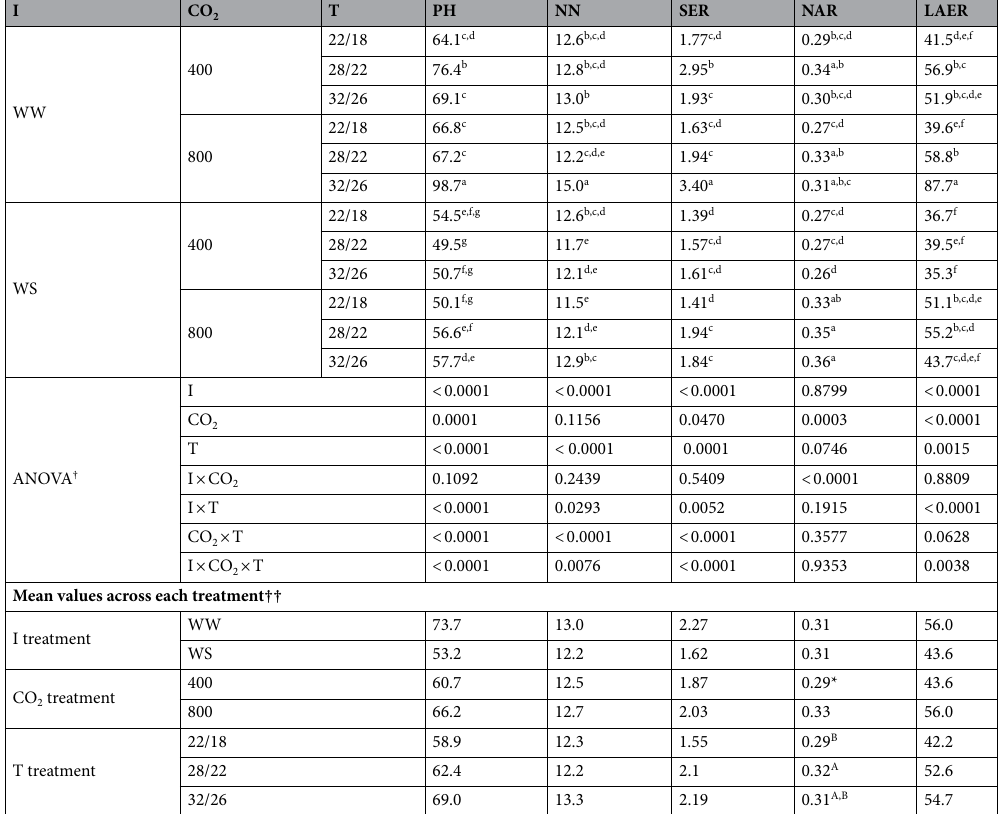
Table 1. Effects of irrigation (I, WW, well water; WS, water stress), CO 2 levels (µmol mol −1 ), and temperature (T, day/night, °C) treatments on plant height (PH, cm), mainstem node number (NN), stem elongation rate (SER, cm/day), node elongation rate (NAR, node/day) and leaf area expansion rate (LAER, cm 2 plant −1 day −1